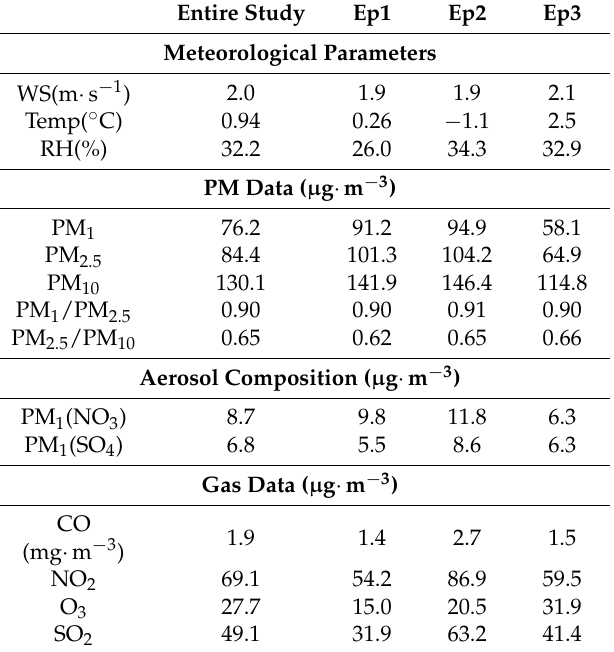
Table 1. A summary of the average meteorological parameters, mass concentrations of PM species, major components and gaseous species for the entire study and the three episodes (Ep1, Ep2, and Ep3) marked in Figure 1. Entire Study Ep1 Ep2